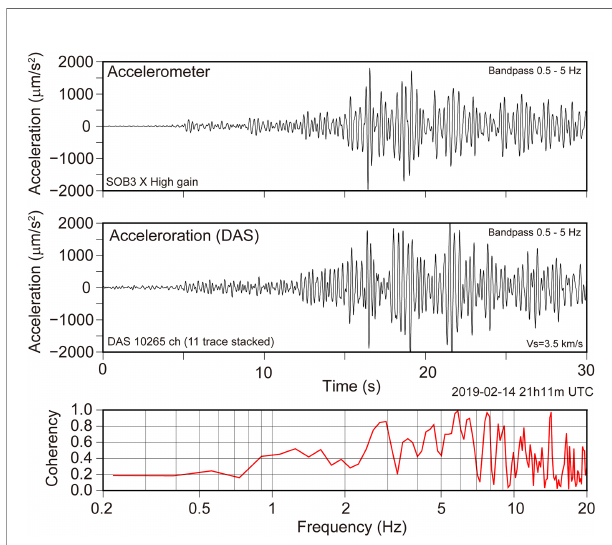
FIGURE 5 | Comparison of the DAS records and records obtained by an accelerometer connected to the cable observation system. The data from the DAS measurement were converted to acceleration to compare the data from the accelerometer (SOB 3). The X-component of the SOB3 is parallel to the sea fl oor cable. The DAS data for the adjacent 11 channels were averaged and transformed to particle acceleration under an assumption of plane wave propagation with a velocity of 3.5 km. Both the records were fi ltered from 2 s to 5 Hz. Coherency between the records from the accelerometer and the acceleration data transformed from the DAS records was calculated. The channel of the DAS records to compare the data of the SOB3 was selected using airgun signals.